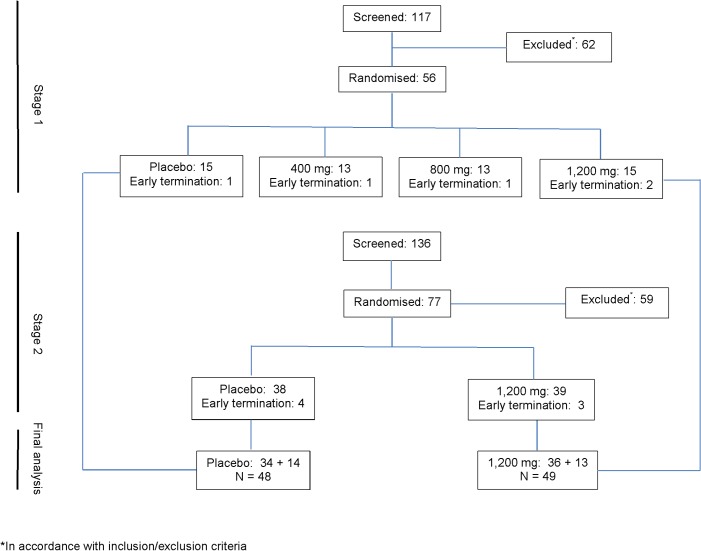
CONSORT diagram.